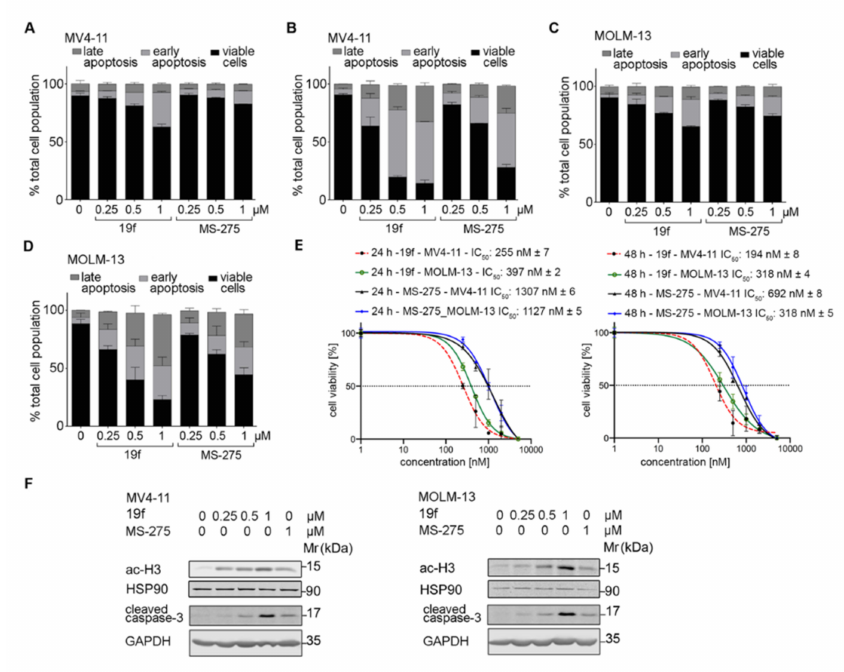
Figure 6. Pro-apoptotic effects of 19f and MS-275 in MV4-11 and MOLM-13 cells. A, B MV4-11 cells were treated with 0.25, 0.5, 1 µ M 19f or MS-275 for 24 h ( A ) or 48 h ( B ) and analyzed for annexin-V/PI by flow cytometry. ( C , D ) The same experiments were conducted with MOLM-13 cells. ( E ) IC 50 values were determined for 19f. ( F ) Immunoblot was done with the stated antibodies and lysates of MV4-11 and MOLM-13 cells that were incubated with the HDACi for 24 h. Cells were incubated with 0.25, 0.5, 1 µ M 19f, or 1 µ M MS-275. Graphs show representatives of three independent